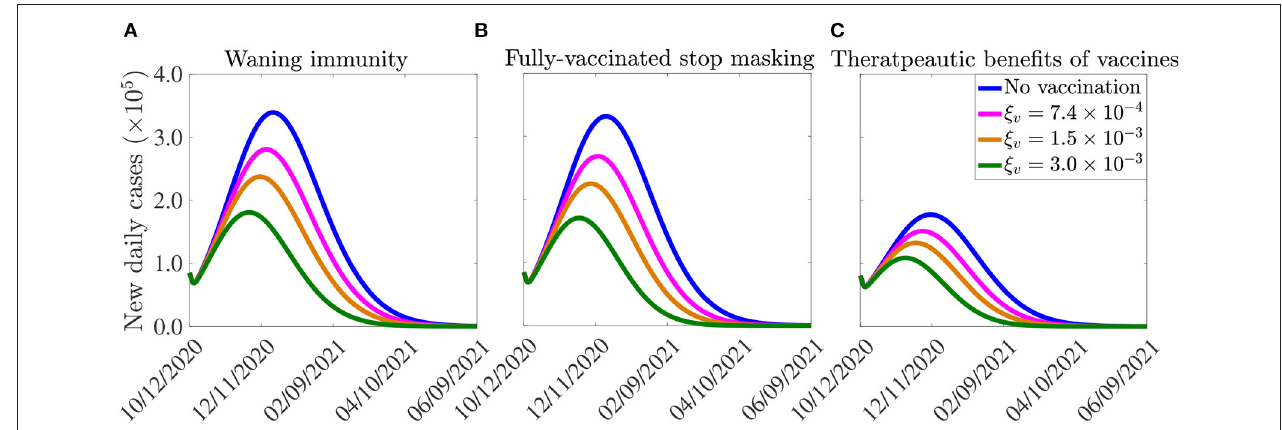
FIGURE 8 | Effect of (A) vaccine-induced and natural immunity waning, (B) unmasking by vaccinated individuals, and (c) therapeutic benefits of vaccines on the burden of the pandemic and the time-to-elimination. The vaccination rates ξ v = 7.4 × 10 − 4 ,1.5 × 10 − 3 ,3.0 × 10 − 3 , per day correspond, respectively, to vaccinating approximately 2.5 × 10 5 ,5.0 × 10 5 ,1.0 × 10 6 people per day. The vaccine-induced and natural immunity waning rate parameters, ω v and ω r , are set to ω v = 1 / 180 per day (44) and ω r = 1 / 270 per day (46), respectively. The effect of therapeutic benefits of the vaccine depicted in (C) is incorporated by reducing the baseline values of the parameters (from Tables 3 , 4 ) that are related to development of severe disease ( r ), hospitalization ( φ jI , j = 1,2) and mortality ( δ jI , δ jH , j = 1,2) by 5 % , in addition to increasing the baseline value of the parameters related to the recovery rate ( γ jI , γ jA , γ jH , j = 1,2) by 5 % . The values of the other parameters of the model used in the simulation are as given in Tables 3 , 4